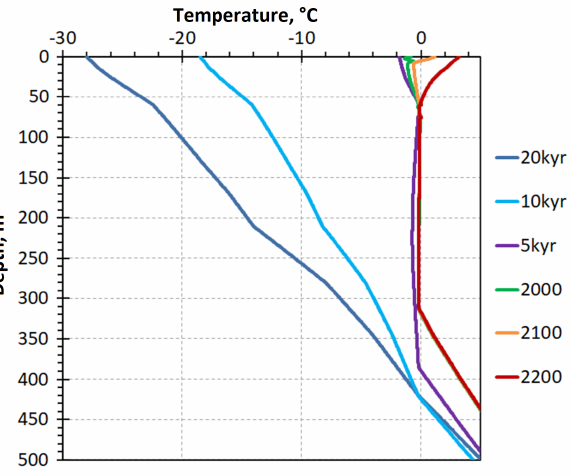
Figure 3. Evolution of the temperature profiles in the upper 500 m of bottom sediments in the past, present and future. The profiles correspond to 20 thousand years ago (20 kyr), 10 thousand years ago (10 kyr), 5 thousand years ago (5 kyr), and the year 2000 (present) as well as the years 2100 and 2200